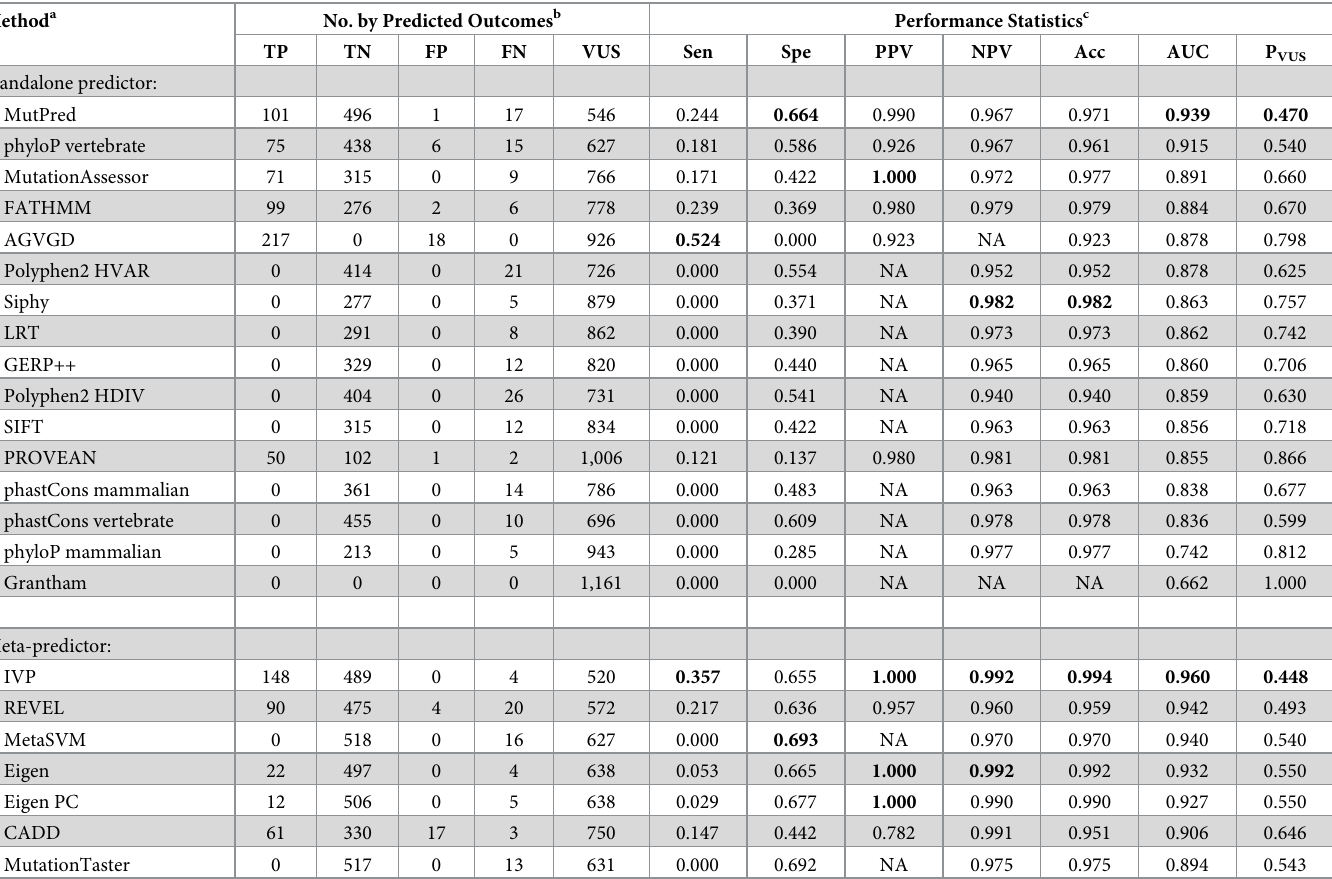
Table 1. In silico variant prediction in MGPT